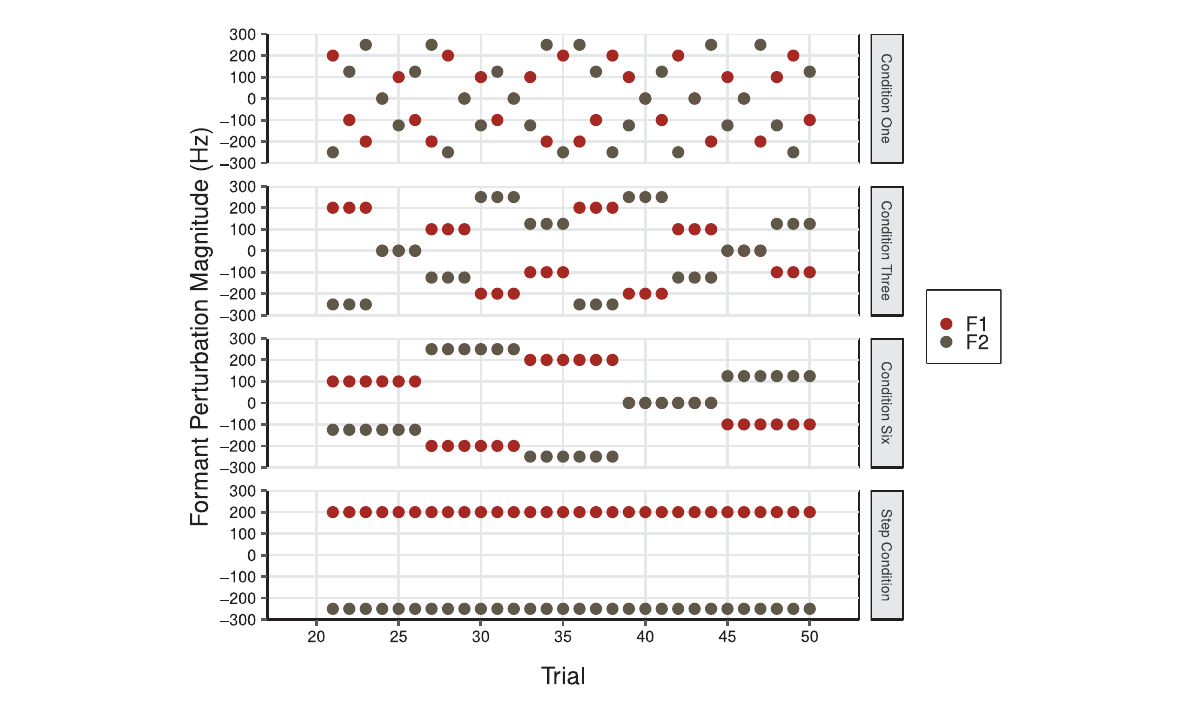
FIGURE6 F1 (red) and F2 (gray) perturbation values in Hz during the Perturbation phase of Condition One, Condition Three, Condition Six, and the Step Condition of Experiment 2. The overall average F1 and F2 perturbation values in Condition One, Three, and Six was 0 Hz (F1 min = –200 Hz, F1 max = 200 Hz; F2 min = –250 Hz, F2 max = 250